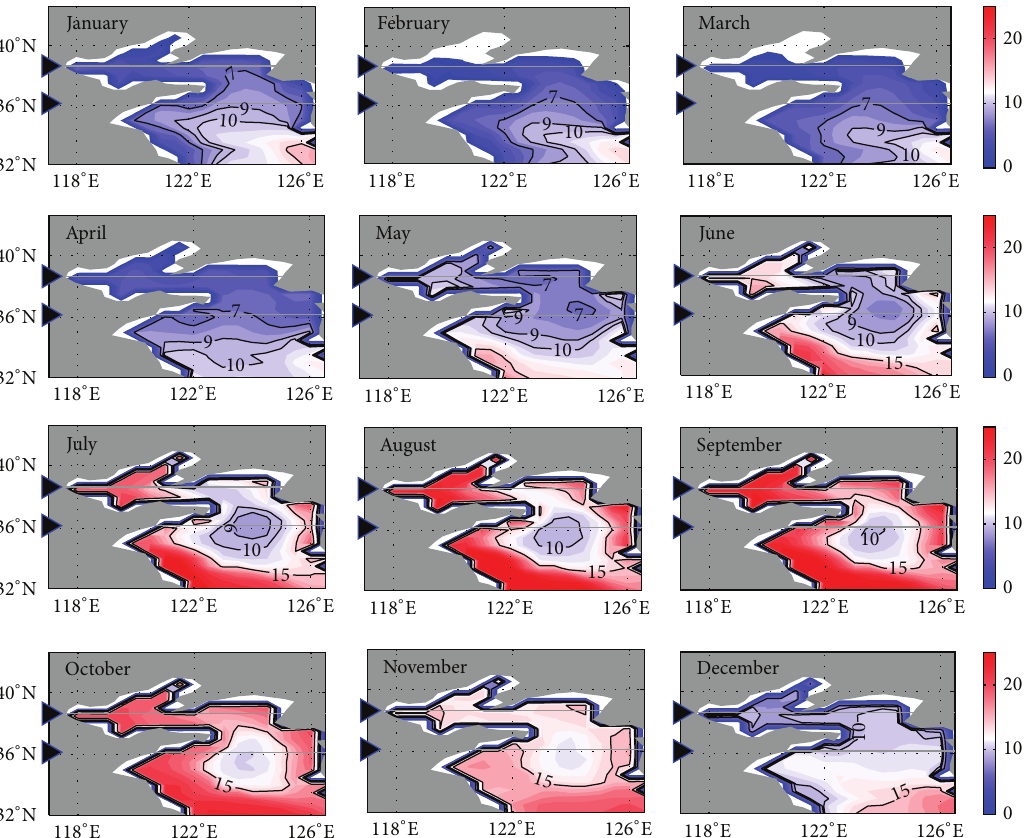
Figure 2: Monthly mean climatology of bottom water temperature ( ∘ C) in the Yellow Sea. The triangles indicate the location where the cross sections are